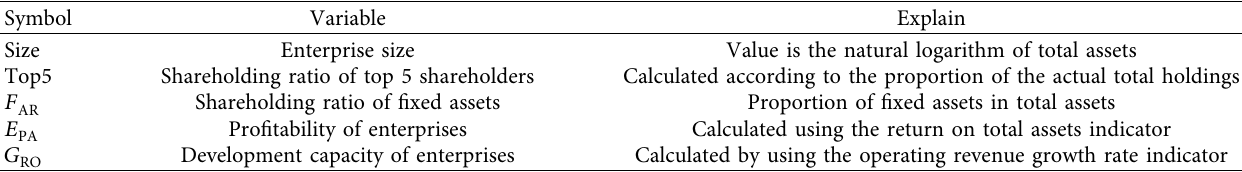
Table 2: Design of model control variables.